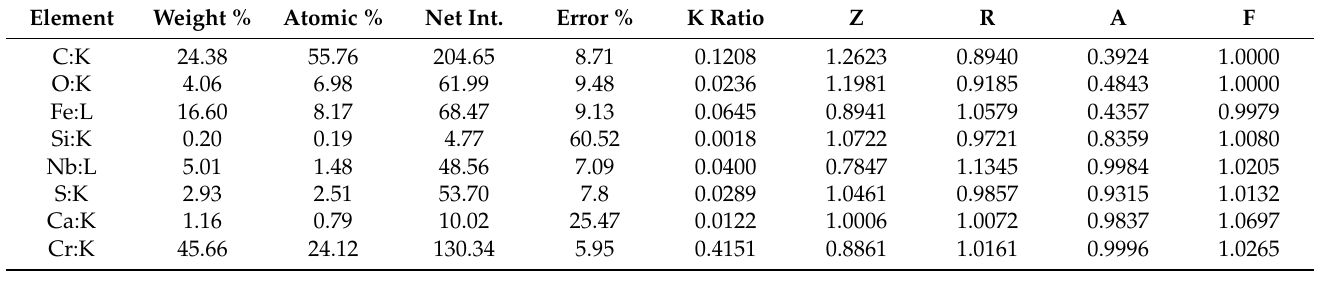
Figure 17. EDS measurement of the first point for specimen No. 5 to study the lack of fusion defect. Table 8. Chemical composition as the result of EDS analysis in specimen No. 5 (first point) to study the lack of fusion defect.